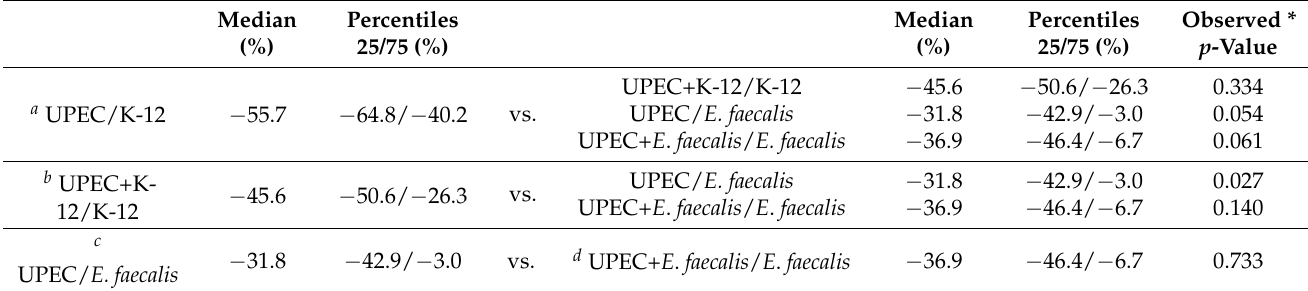
Table 2. Inferential evaluation of indices and related median, 25th, and 75th percentiles for the overall six pairwise associations among indices obtained from the different infections of the 5637 bladder cell